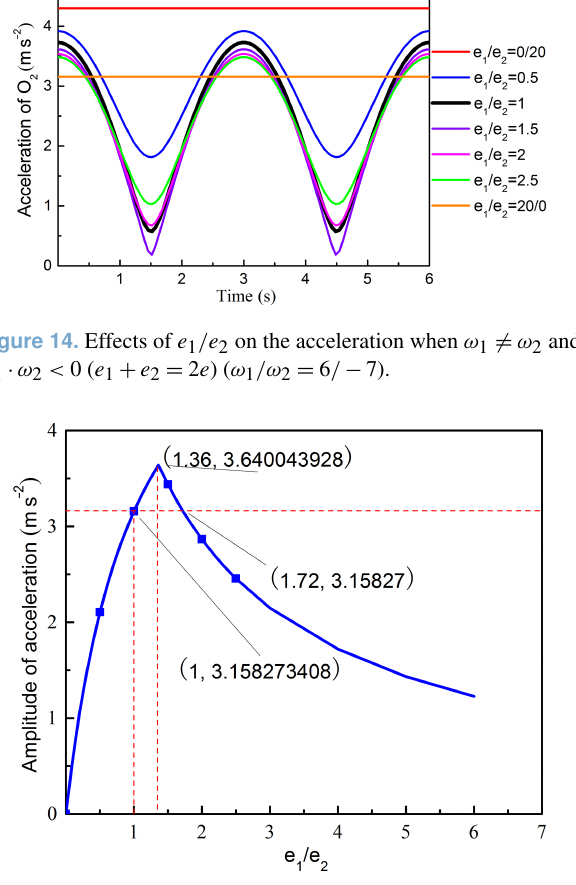
Figure 15. Effects of e 1 /e 2 on the amplitude when ω 1 (cid:54)= ω 2